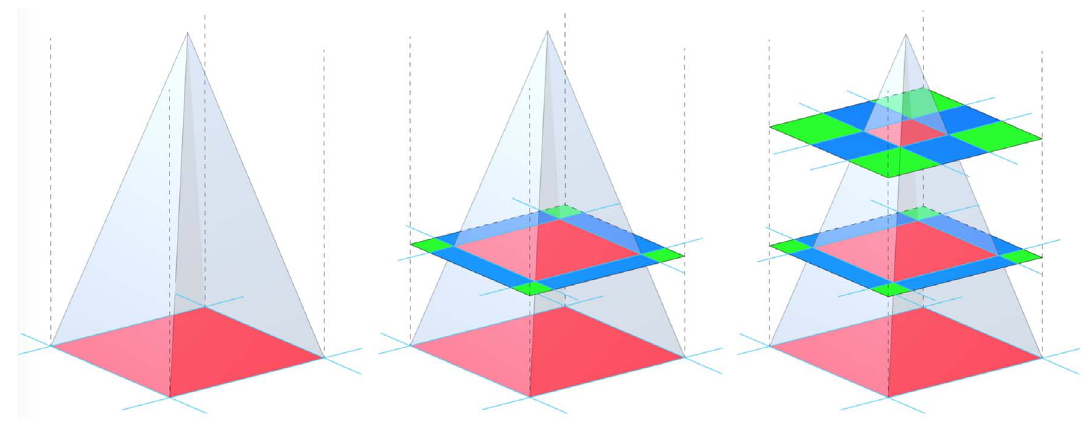
Figure 17. Projections along a pyramid. The solid blue lines are cutting